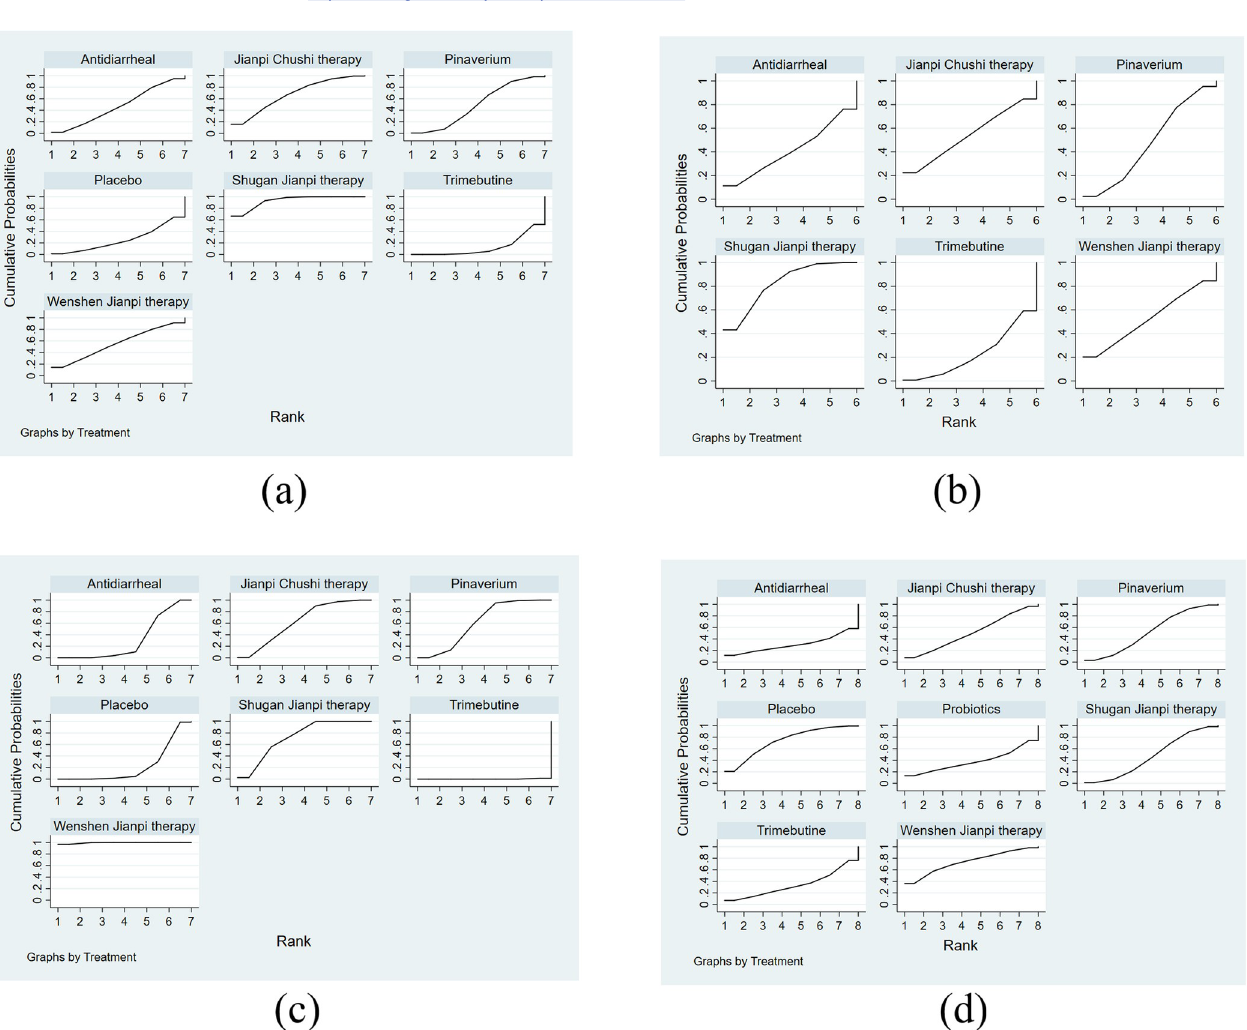
Fig 9. Surface under the cumulative ranking curve plot: (a) Abdominal pain; (b) Abdominal distension; (c) Stool character; (d) Adverse effects. https://doi.org/10.1371/journal.pone.0255665.g009 PLOS ONE | https://doi.org/10.1371/journal.pone.0255665 August 6,